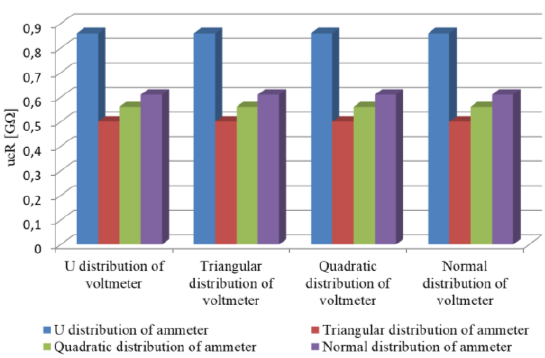
Fig. 1. Combined standard uncertainty of the resistance measurement depending on the selected probability distribution when testing the resistor 100 GΩ